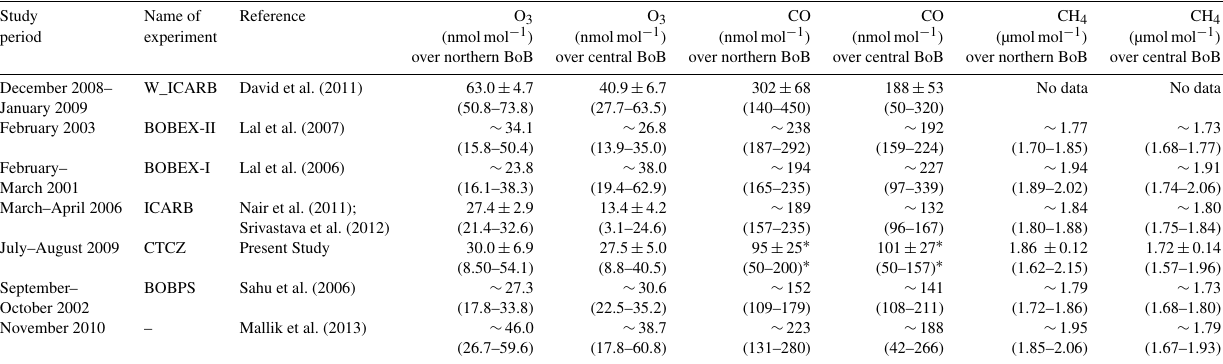
Figure 8. Surface O 3 (black dots) along with temperature (orange curve) and 3h rainfall (grey vertical bar) during the four events of sharp decline in O 3 ( a – d ) as marked in Fig. 4c. Colours indicate the vertical wind as simulated by WRF-Chem. Table 4. A comparison of average mixing ratios of surface trace gases measured over northern BoB (81–91 ◦ E, 16–21.5 ◦ N) and central BoB (80–91 ◦ E, 11–16 ◦ N) in different seasons as measured during different experiments. The range of mixing ratios (i.e. minima–maxima) is given in the